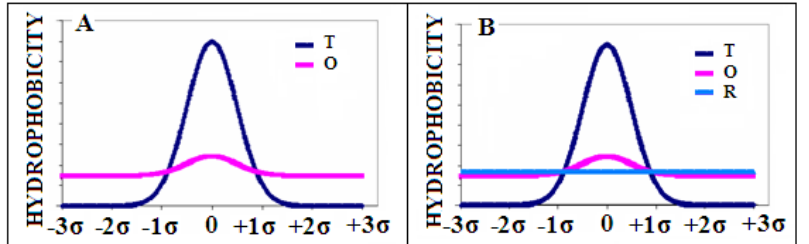
Figure 10. Examples of distributions: ( A )—distribution O (pink) and reference Gaussian distribution T (with parameter 𝜎 ) expressing the presence of the central hydrophobic core (dark blue). ( B )—the second reference distribution R (light blue) superimposed—expressing a lack of any variation in hydrophobicity.